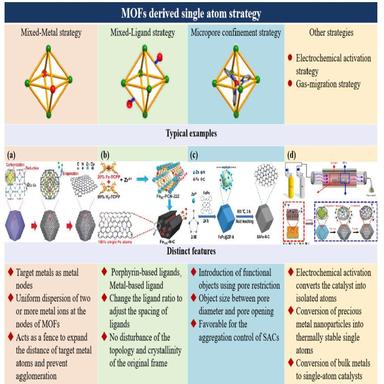
Fabrication strategies of MOF-derived SACs. (a) Mixed-metal strategy. Copyright 2016 Wiley. (b) Mixed-ligand strategy. Copyright 2018 Wiley. (c) Micropore confinement strategy . Copyright 2021 Elsevier. (d) Other strategies. Copyright 2018 Nature.